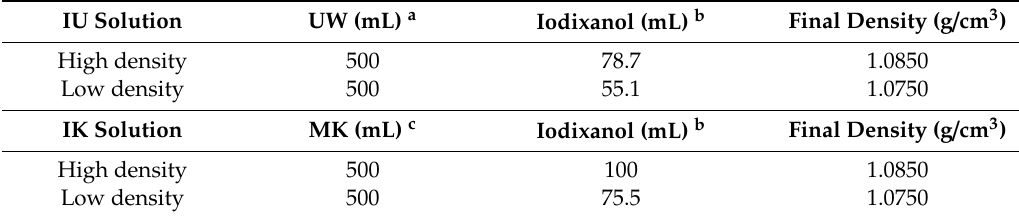
Table 2. Characteristics of each purification solution.